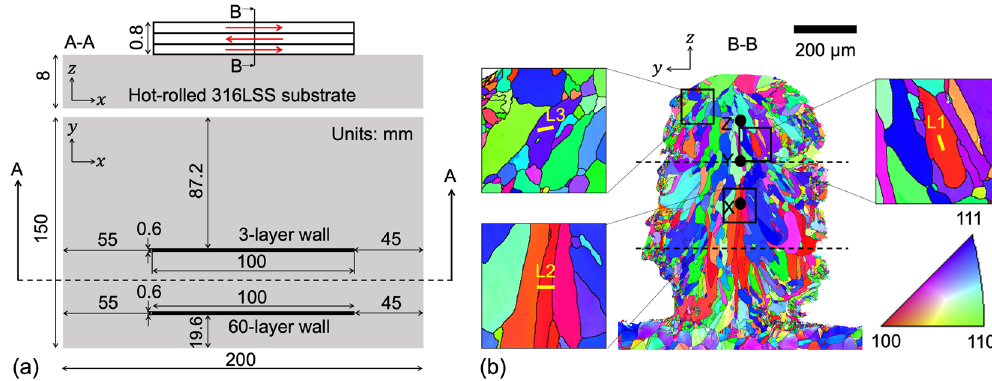
Figure 1. Design and crystallographic orientation map of the LMD 316LSS walls from which TEM lamellae are extracted. (a) An illustration (not-to-scale) of the single-track bidirectionally-printed 3-layer and 60-layer LMD 316LSS walls on a hot-rolled 316LSS substrate. Directions x , y and z respectively represent the printing, thickness and building directions. The top view and the front view of a cross-section A–A are shown. The red arrows in the front-view show the direction of printing of each layer. (b) An EBSD orientation map color- coded according to IPF along building direction at a cross-section B–B approximately at the mid-section of the 3-layer wall. Dotted lines in (b) represent the approximate position of interlayer boundaries. The black solid circles in (b) indicate the points X, Y and Z that correspond to the locations in the FE simulations from where the temperature vs time data has been extracted and plotted in Fig. 7. Subfigures in (b) show zoomed-in EBSD maps. Yellow-colored lines demark zones underneath which lamellae L1, L2 and L3 are extracted (in the out-of- plane direction). These lines correspond to the top side of L1, L2 and L3 in the HAADF images in Fig. 2.